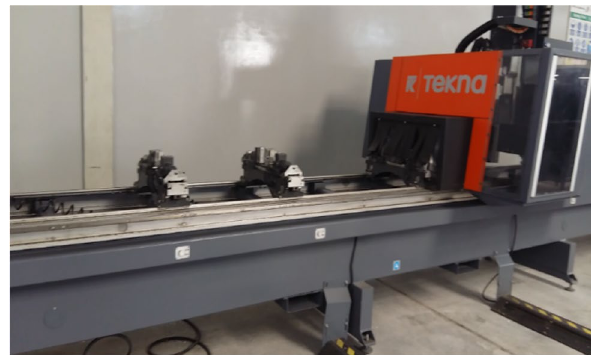
Fig. 1 Experimental setup during end milling